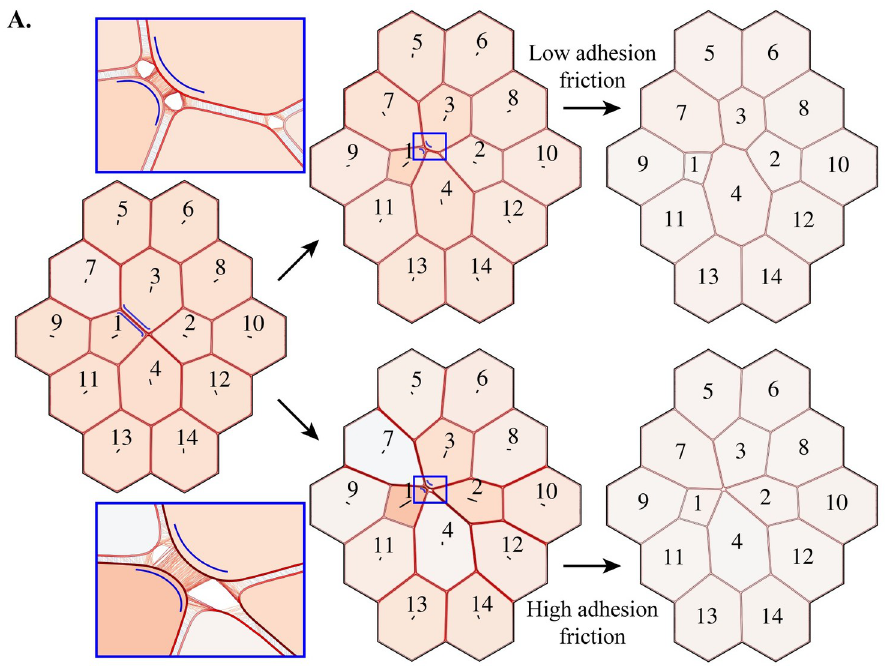
Fig 6. Rosette formation is regulated by the resistance to cell-cell slippage. (A) The simulation from Fig 3 was stopped just as the {3, 4} junction had formed. Active contractility ( γ = 0.94) was then applied to the {1, 3} junction. If the cortical remodelling time is comparable to the adhesion turnover time ( τ adh * τ cor , top; S10 Movie), the {3, 4} junction extends. However, if the adhesion timescale is much larger ( τ adh > τ cor ), preventing slippage between neighbouring cells, the {3, 4} does not resolve (bottom; S11 Movie). Instead, two vertices are merged to form a rosette structure. The rosette is stable while all cells have a small pre-stress, γ 0